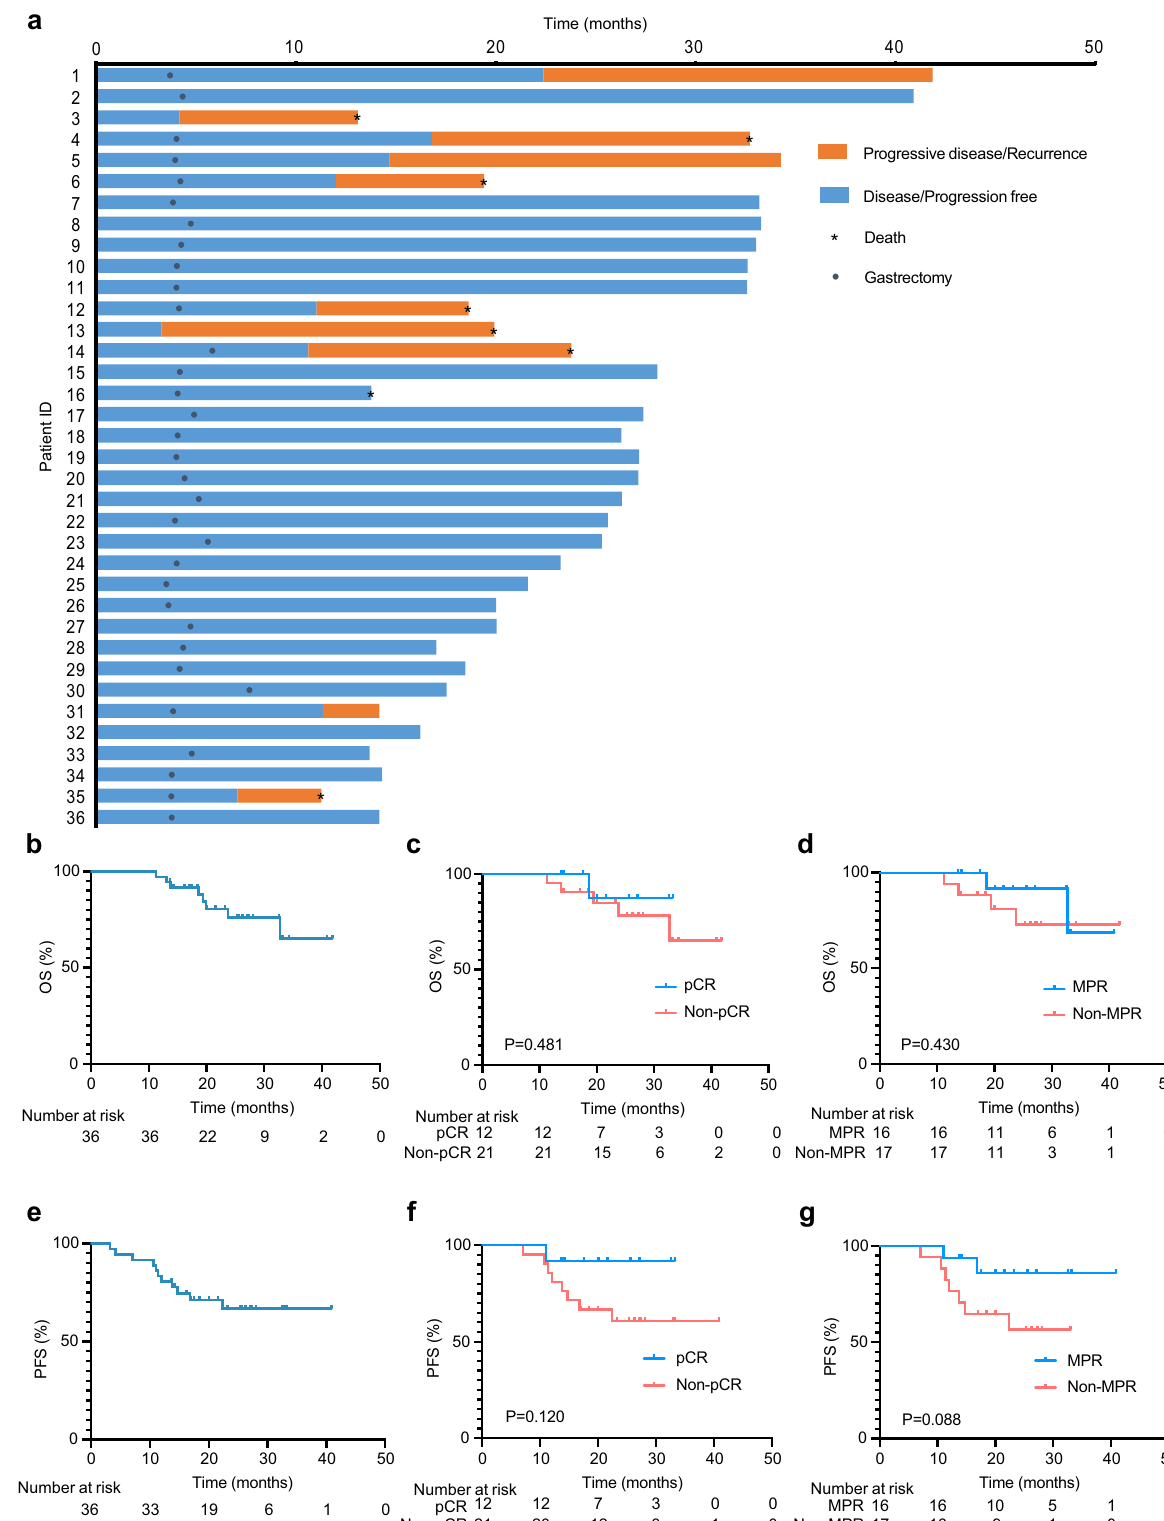
Fig.3|Follow-upandsurvival.a Swimmingplotshowingeventsduringtreatment andfollow-up( n =36). b Kaplan – Meiercurvesforoverallsurvivalinthefullanalysis set. c Kaplan – Meier curves for overall survival in patients with or without pCR. A two-sided log-rank test was used to determine the statistical signi fi cance between subgroups. d Kaplan – Meier curves for overall survival in patients with or without MPR. A two-sided log-rank test was used to determine the statistical signi fi cance betweensubgroups. e Kaplan – Meiercurvesforprogression-freesurvivalinthefull